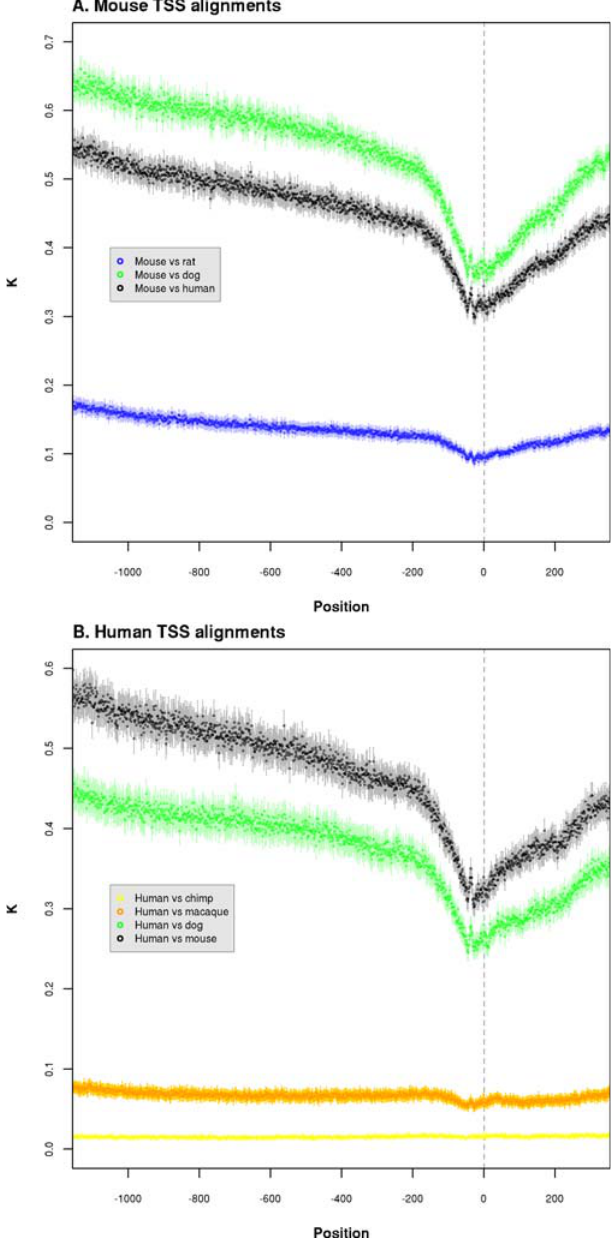
Figure 1. High-Resolution Pairwise Substitution Rate Estimates (K) across Promoter Region Alignments The x- axis denotes nucleotide position relative to the TSS reference position at þ 1 (grey vertical line). Error bars (lighter shading) show 95% confidence intervals for each data point. (A) Rates calculated from mouse-based alignments. (B) Rates calculated from human-based alignments. DOI: 10.1371/journal.pgen.0020030.g001